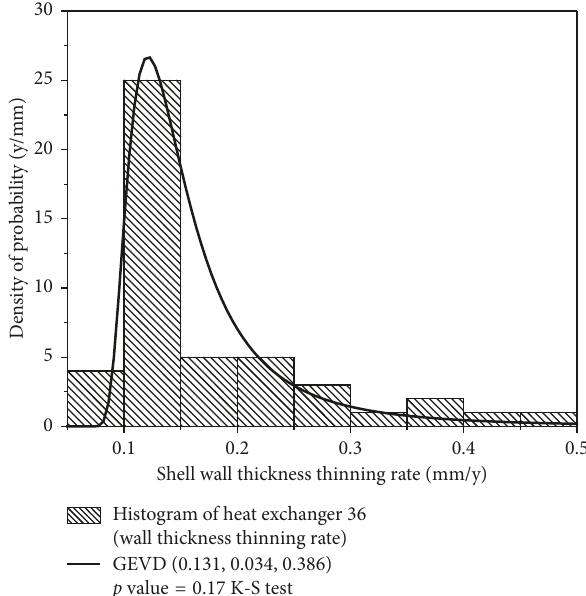
Figure 1: Wall thickness thinning rate of heat exchanger histogram and its fitting to GEVD (all the Probability Density Function (PDF) values plotted in this paper were adjusted in order for the distri- bution to “look like” the histogram. To do this, it is necessary to convert the PDF to the histogram’s size using the bins’ width and the number of bins. Reference [44] explains this process in detail).